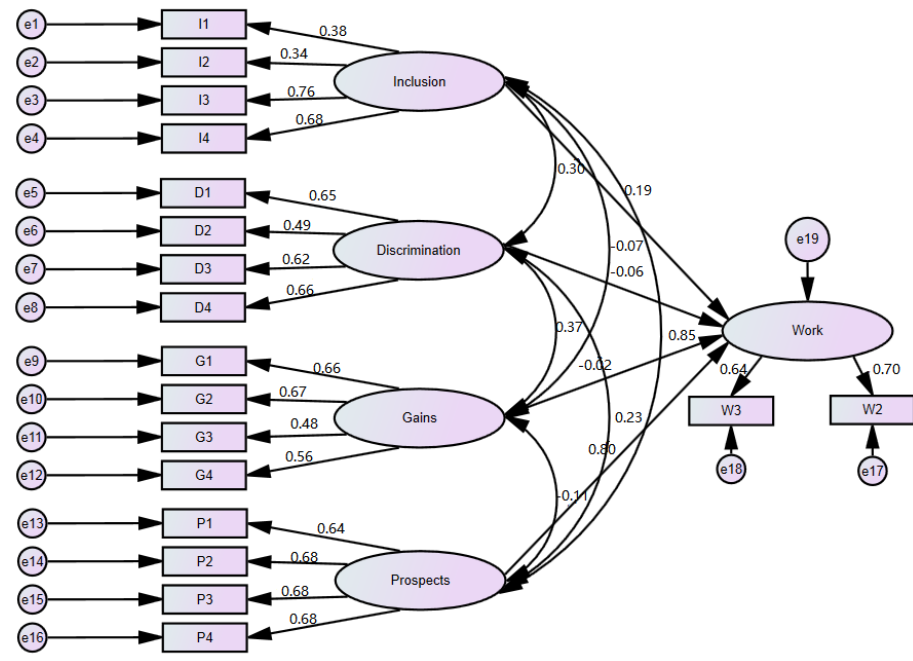
Figure 2. Structural equation model—standardized estimates.